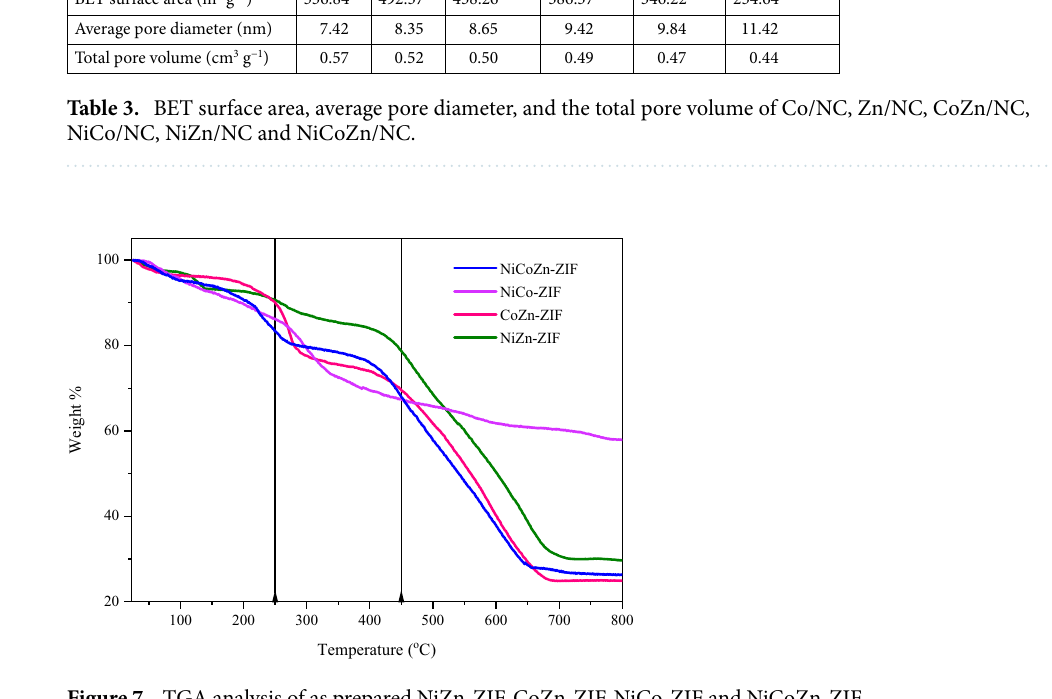
Figure 9 indicated the conversion of each catalyst in the hydrogenation of PyGas. The commercial Pd/Al 2 O 3 catalyst showed a 70.9% conversion of total olefins and NiCo/NC showed 69.5% conversion of total olefins which